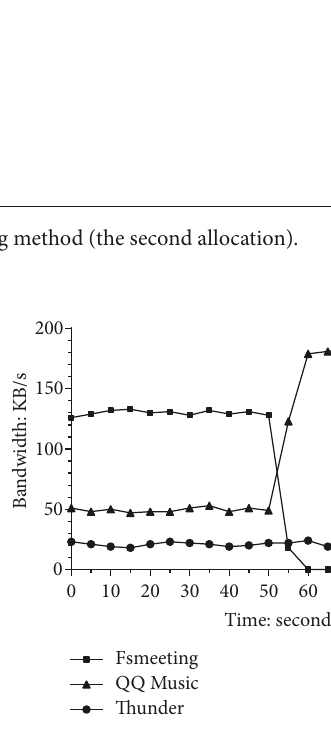
Figure 5: Bandwidth usage for three